Question: Compose a caption that would accompany this figure in a paper.
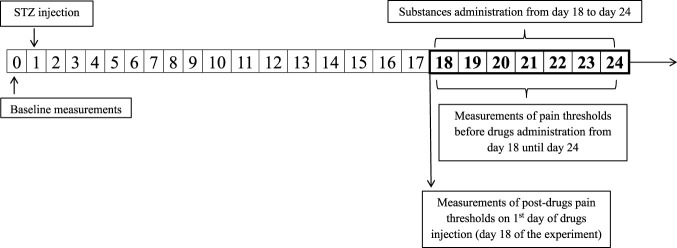
Answer: Timeline of the experimental procedure.